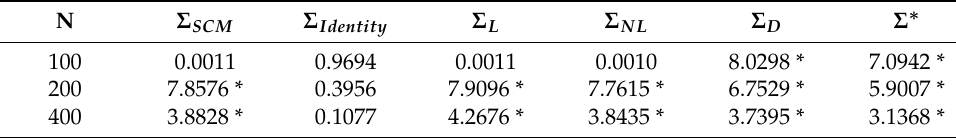
Table 5. The variance comparison of six estimations in the minimum variance